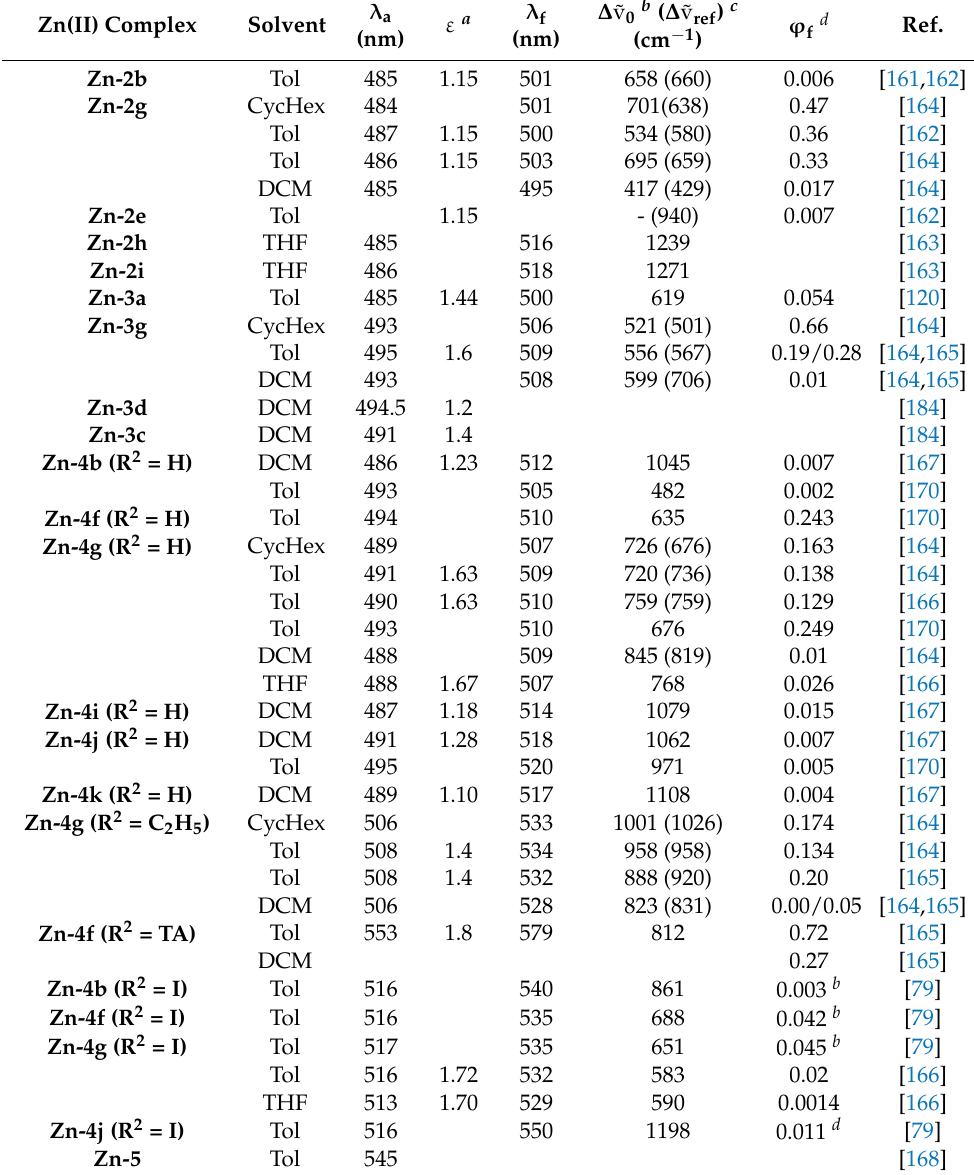
Table A1. Absorption and emission properties of homoleptic bis(dipyrrinato)Zn(II)